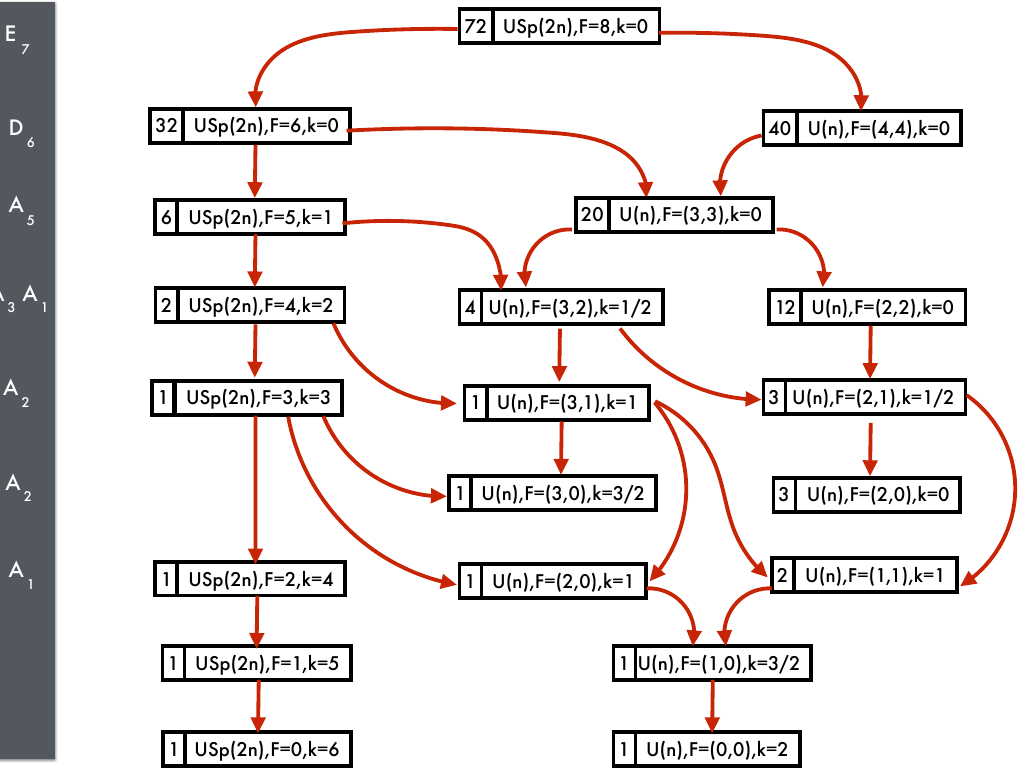
Figure 2 . Weyl group symmetry enhancements obtained from USp(2 N c ) with eight fundamentals and antisymmetric de(cid:12)ned on R 3 (cid:2) S 1 . The rectangles represent the partition function of sets of 3d N = 2 models, with gauge group USp(2 N c ) 2 k or U( N c ) (cid:0) k , where k refers to the CS level. In